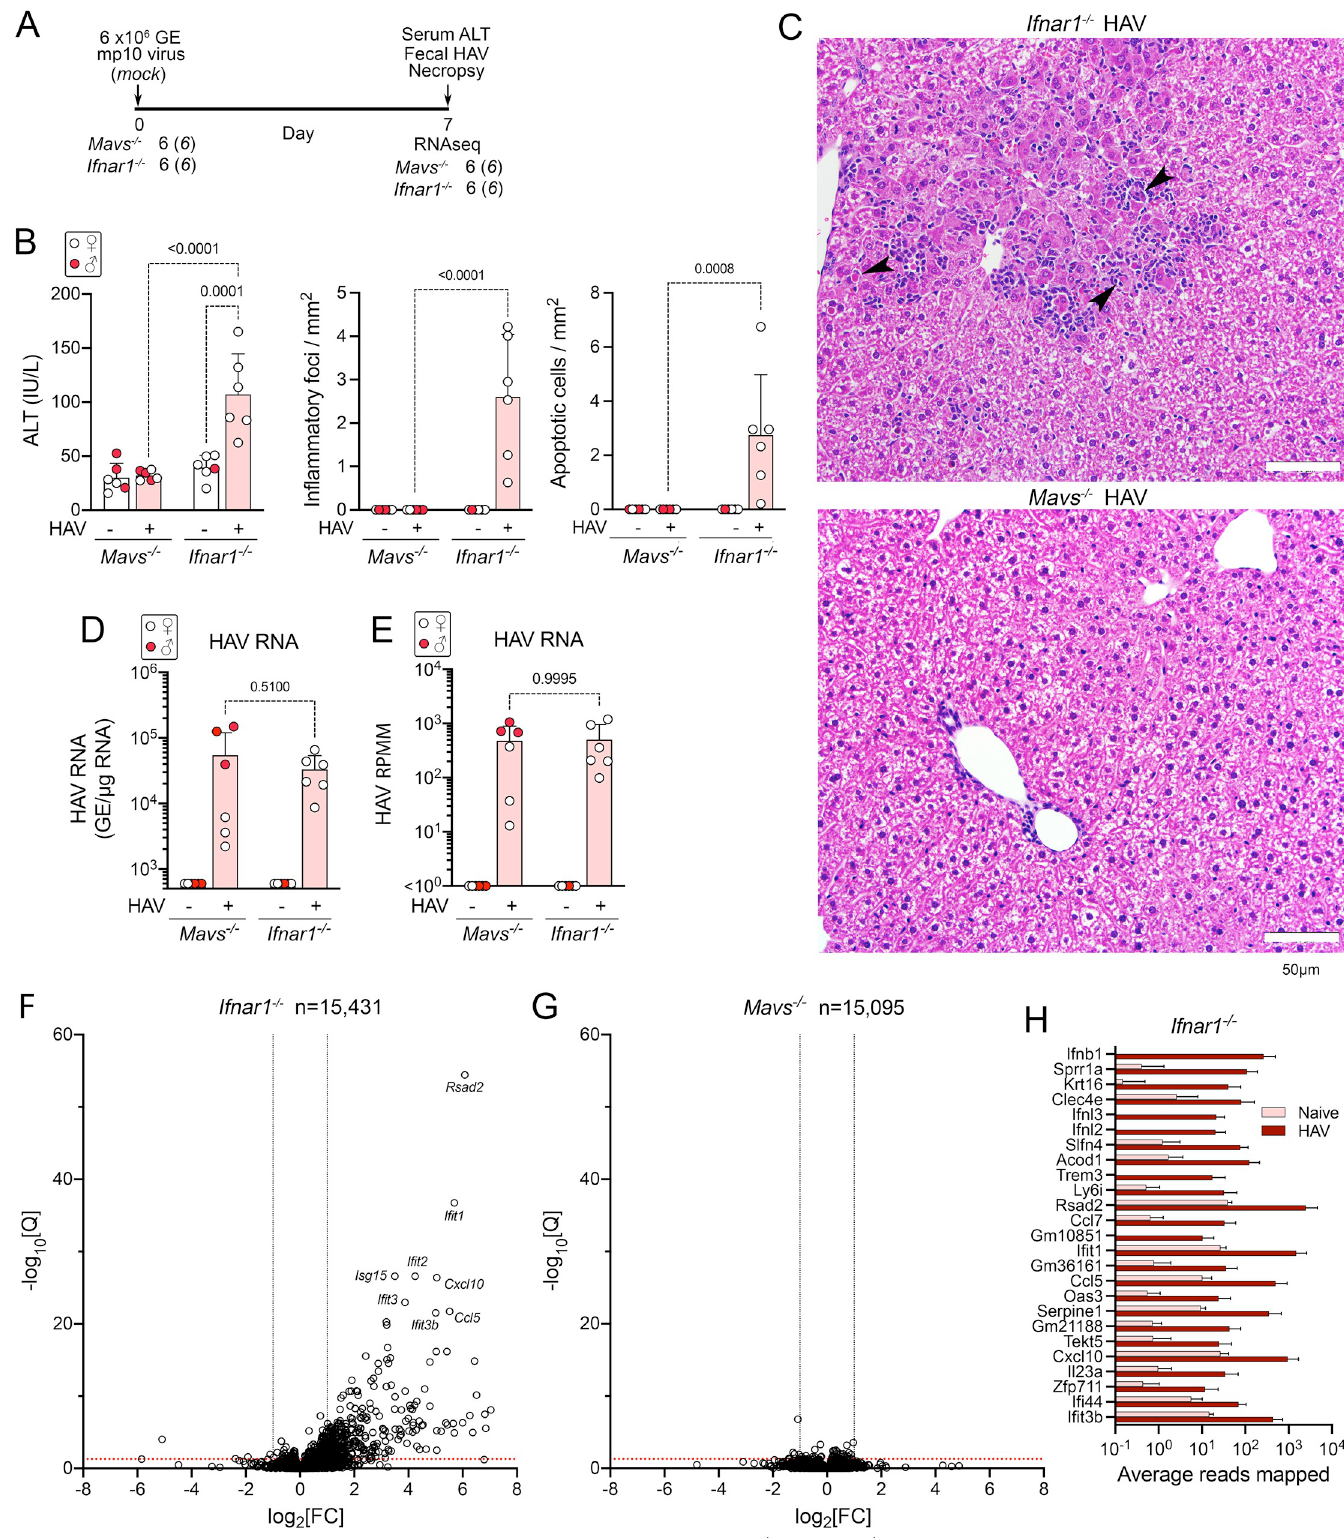
Fig 1. Infection-induced changes in the intrahepatic transcriptome of HAV-infected Mavs -/- and Ifnar1 -/- mice. (A) Experimental scheme showing numbers of mice inoculated with 6 x10 6 genome equivalents (GE) of HM175-mp10 virus. (B) ( left ) Serum alanine transaminase (ALT) activities in sera of HAV-infected and mock-